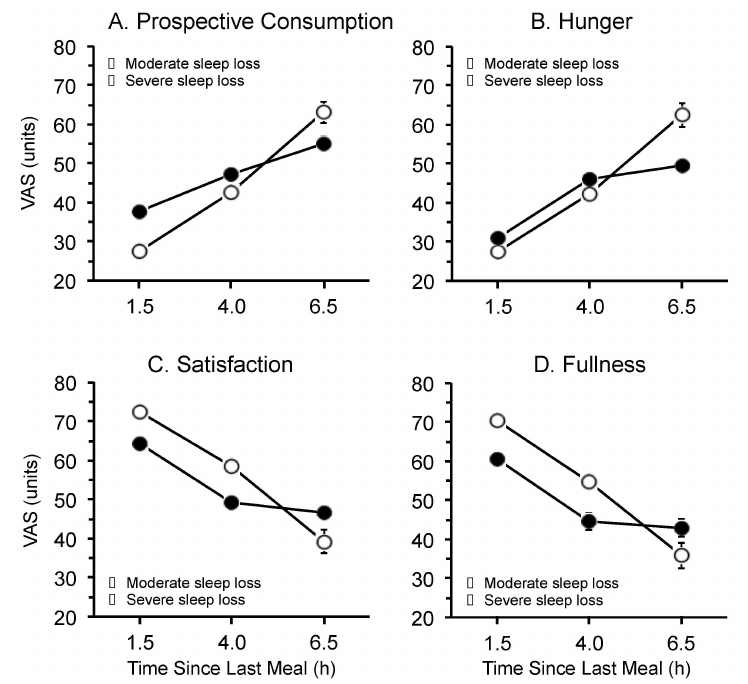
Figure 3. Main effect of time since last meal on ( A ) prospective consumption; ( B ) hunger; ( C ) satisfaction; and ( D ) fullness during the forced desynchrony segment of the protocol for participants in the moderate sleep restriction condition (open circles) and the severe sleep restriction condition (closed circles). Data are mean ˘ SEM (N.B. in some cases error bars are obscured by the symbols)